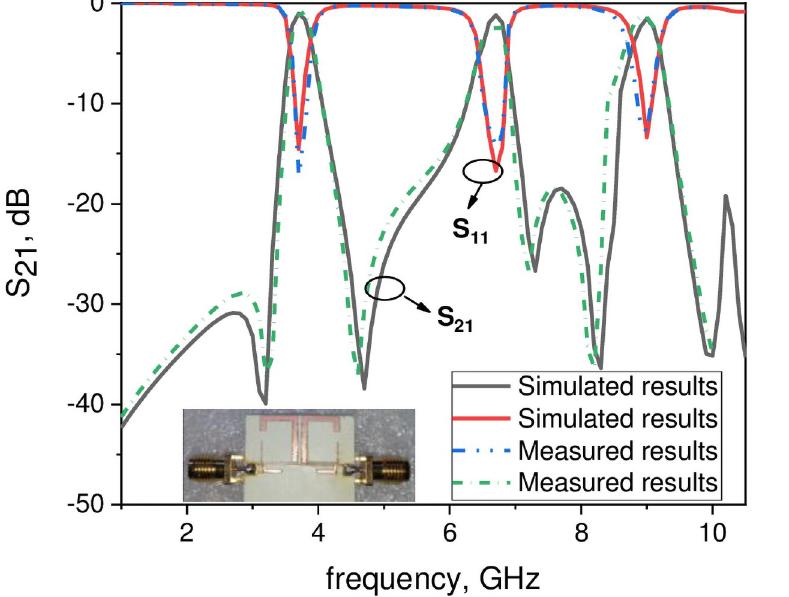
Fig 10. Simulated and measured resonance frequency plots of the proposed filter.